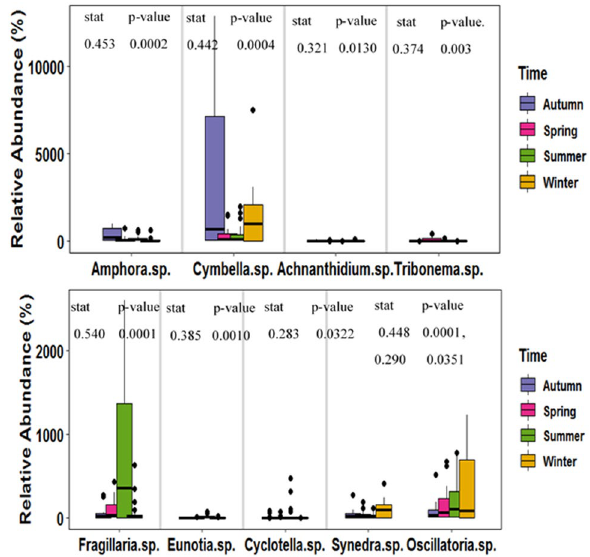
Figure 3. Relative abundance of occurrence of each taxa in different